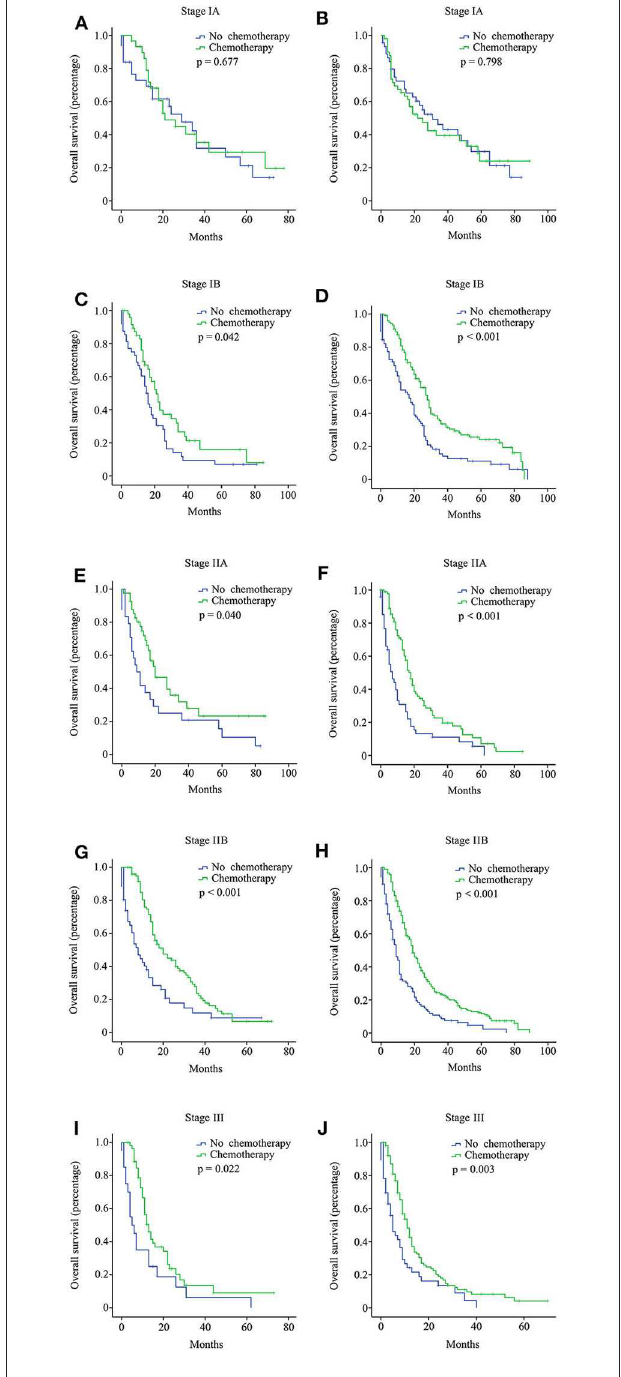
FIGURE 3 | Overall survival (OS) curves for pancreatic ductal adenocarcinoma (PDAC) patients with different stages from the multi-institutional dataset according to the 8th American Joint Committee on Cancer (AJCC) staging system. Stage IA with 15 or more resected lymph nodes (A) ; stage IA with < 15 resected lymph nodes (B) ; stage IB with 15 or more resected lymph nodes (C) ; stage IB with < 15 resected lymph nodes (D) ; stage IIA with 15 or more resected lymph nodes (E) ; stage IIA with < 15 resected lymph nodes (F) ; stage IIB with 15 or more resected lymph nodes (G) ; stage IIB with < 15 resected lymph nodes (H) ; stage III with 15 or more resected lymph nodes (I) ; stage III with < 15 resected lymph nodes (J)